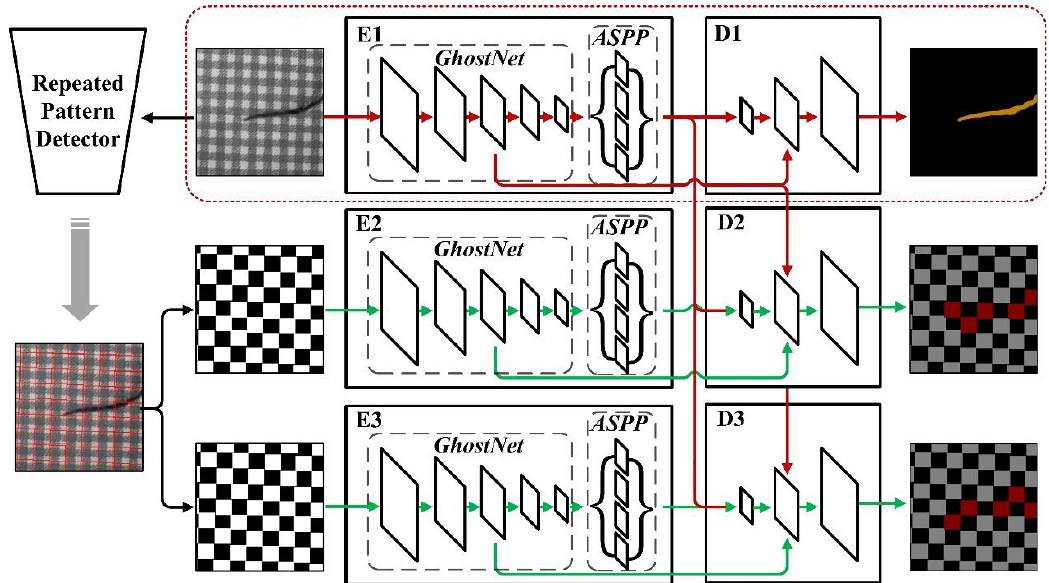
Figure 3. The process of our method. The red dotted box represents the model at the recognition stage. The model allows for network interaction during training by establishing information communication among a set of parallel DeeplabV3+ networks. E and D represent the encoder network and decoder network of DeeplabV3+, respectively.